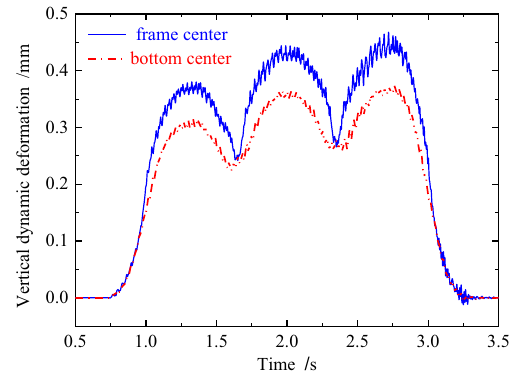
Fig. 8 The vertical dynamic displacement time–history curves of at- ground